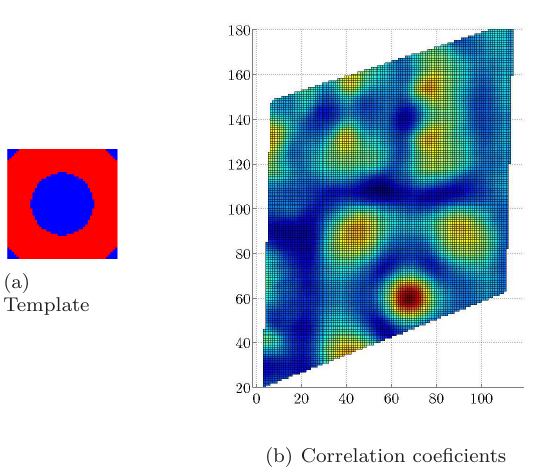
Figure 4: Template and correlations of image matching The greatest correlation coefficient equals ρ